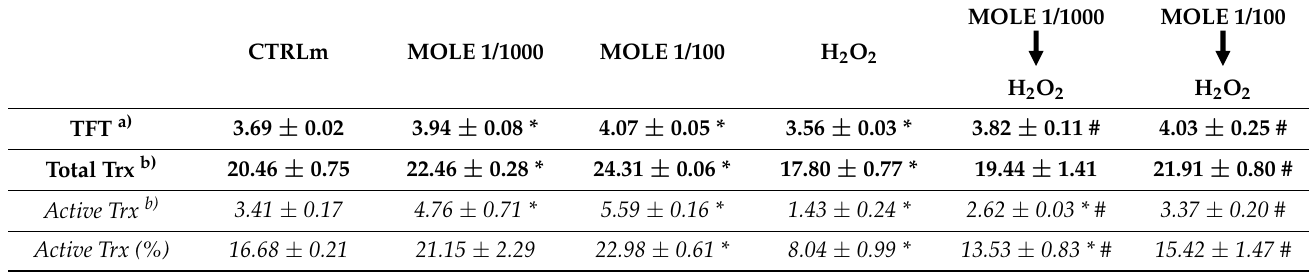
Table 1. Total free thiols and Thioredoxin activity analysis.